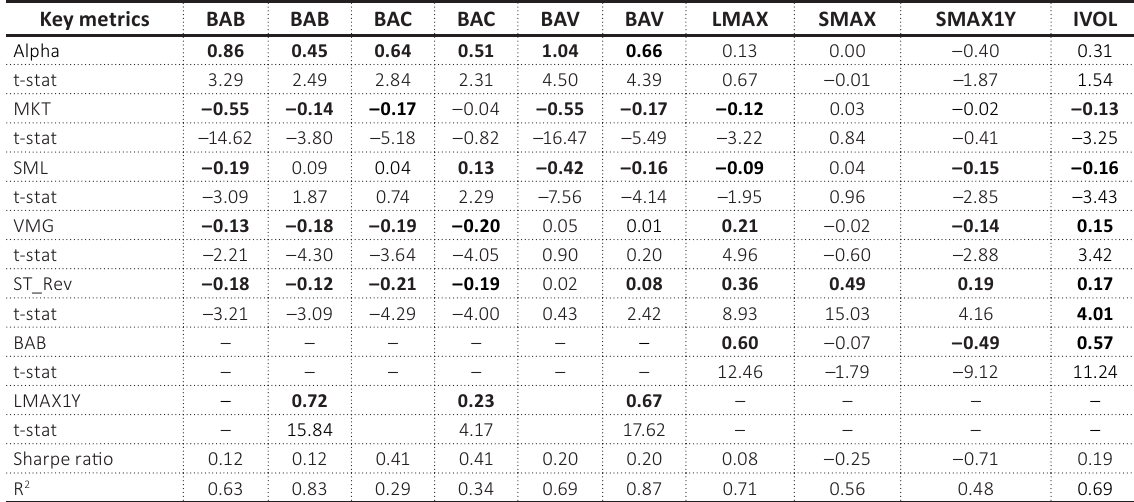
Table 10. Performance marathon among factors constructed using the Fama-French method